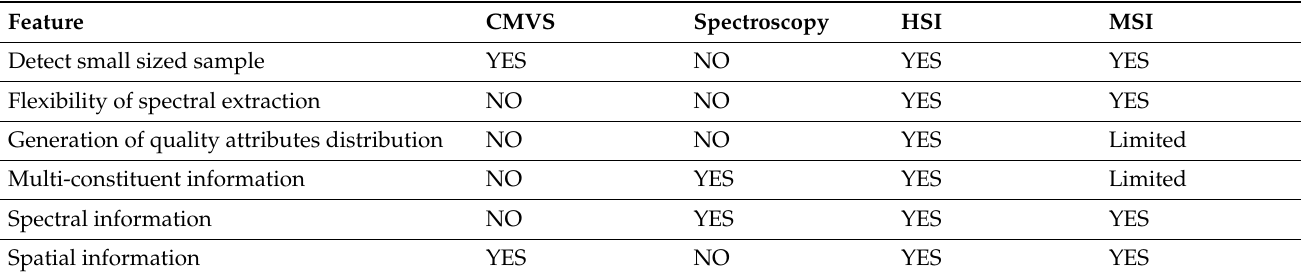
Table 5. Comparison of conventional machine vision (CMVS), near-infrared spectroscopy (NIRS), multispectral imaging (MSI) and hyperspectral imaging